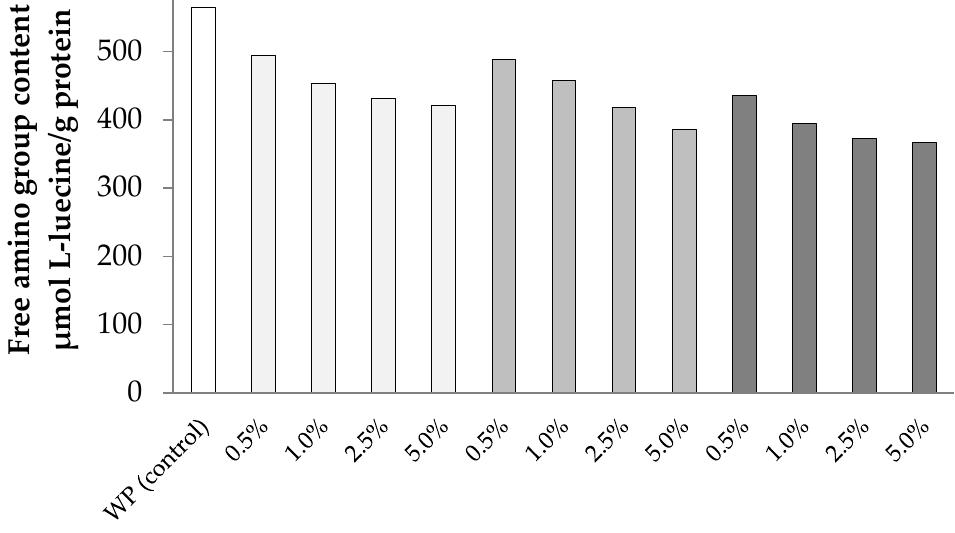
Figure 2. Free amino group content of whey protein modified with different oxidized phenolic compounds at various concentrations. Different letters in the same concentration of oxidized phenolic compounds indicate significant differences. Different capital letters in the same type of oxidized phenolic compounds and control indicate significant differences.